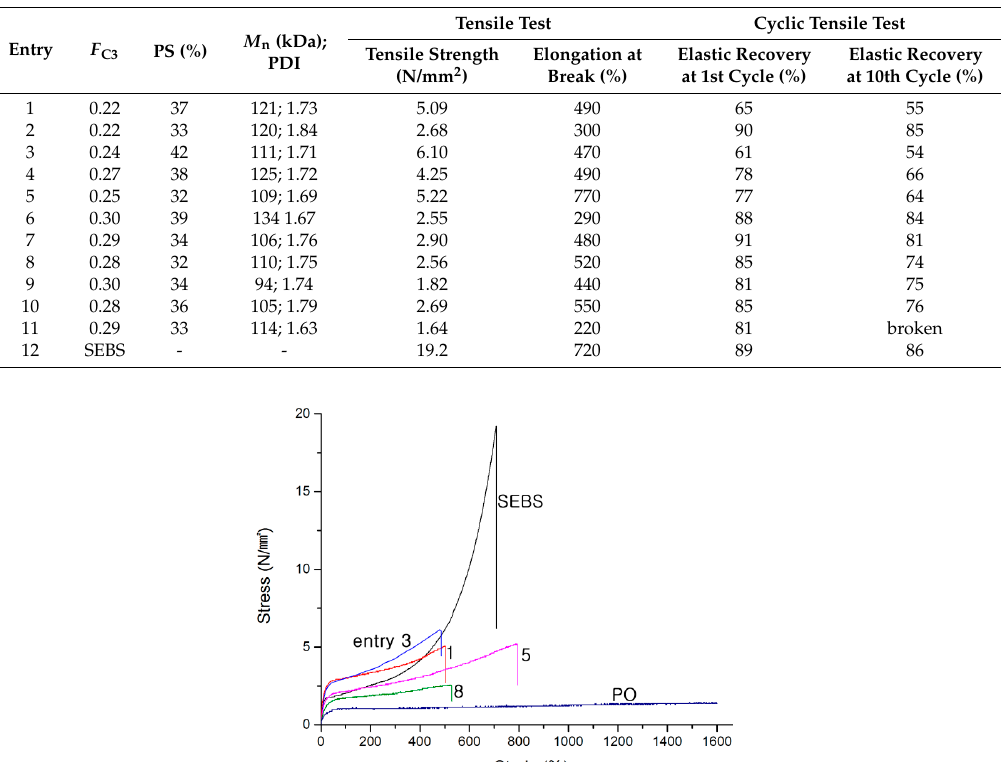
Table 2. Results of the tensile test and the cyclic tensile test.